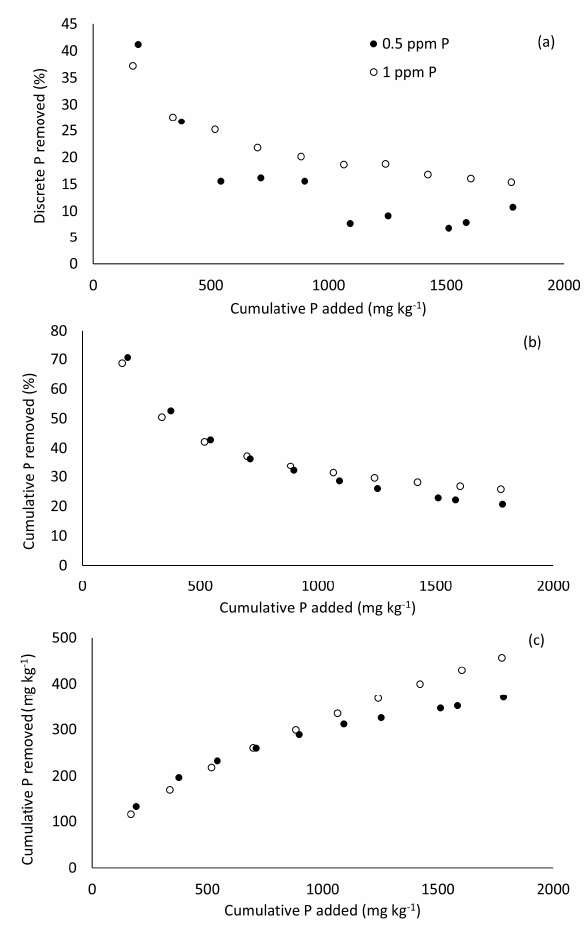
Figure 1. Examples of: ( a ) discrete P removal curve; ( b ) cumulative P removal curve expressed as a percentage; and ( c ) cumulative P removal curve expressed as mg P removed kg − 1 P sorption material (PSM). Flow-through experiment conducted at a retention time of 16 s with inflow dissolved P concentrations of 0.5 and 1 mg L − 1 . The PSM in this example is a Fe-rich mine drainage residual (MDR).